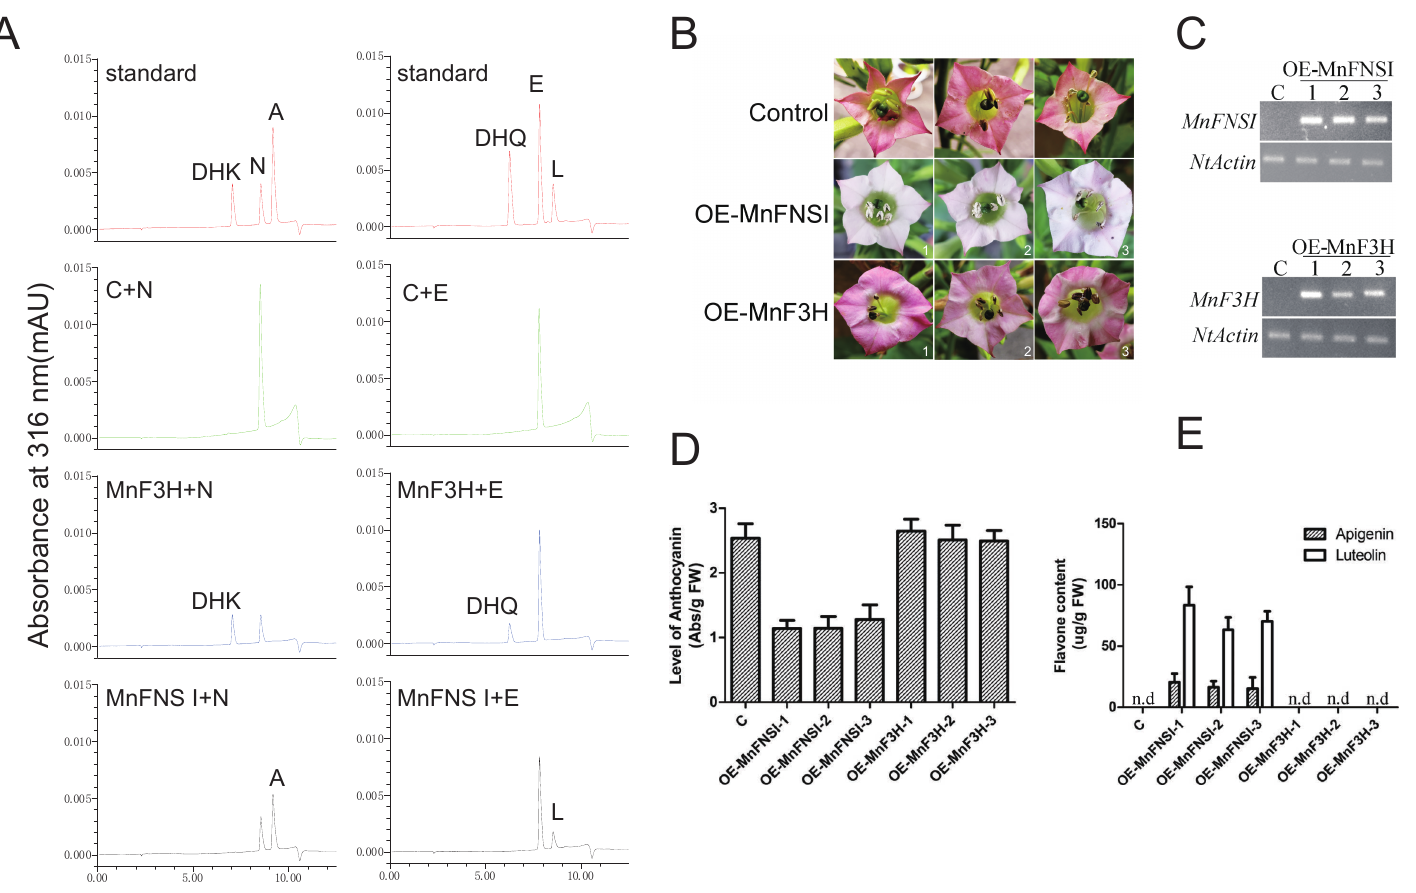
Figure 3. Functional characterization of MnFNSI. ( A ) UPLC chromatograms of products from MnFNSI and MnF3H with naringenin and eriodictyol as substrates. C: bovine serum albumin; A: apigenin; L: luteolin; N: naringenin; E: eriodictyol; DHK: dihydrokaempferol; DHQ: dihydroquercetin. ( B ) Phenotypes of transgenic tobacco harboring MnFNSI and MnF3H . ( C ) Detection of transgene expression by semi-quantitative RT-PCR analysis. NtActin was used as internal control gene. ( D ) Anthocyanin contents in control and transgenic tobacco flowers. ( E ) Flavone contents in flowers of control and transgenic tobacco